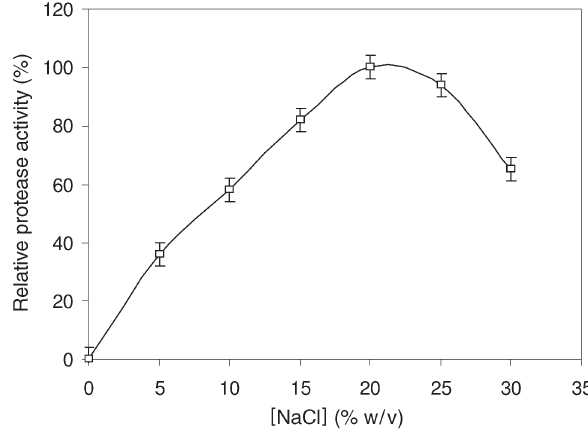
Figure 3. Effect of temperature on purified protease activity. Azo- caseinolytic activity was determined in 0.1 M glycine-NaOH buffer (pH 10.0) with 20% NaCl at each temperature after incubation for 15 min with 100 mM Ca 2+ ( (cid:2) ) and without 100 mM Ca 2+ ( (cid:3) ). Each value represents the mean ± SE of three independent experiments.